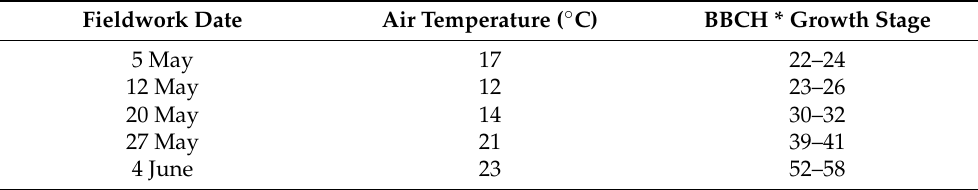
Table 1. Summary of fieldwork data acquisitions.